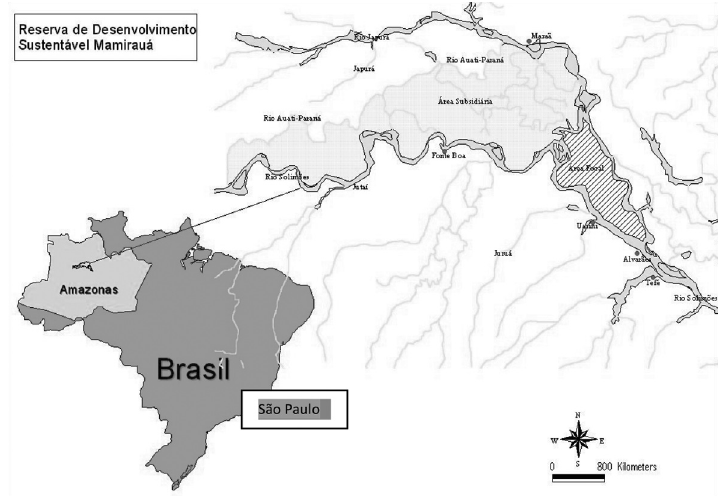
Figure 1. Mamirauá Sustainable Development Reserve and São Paulo